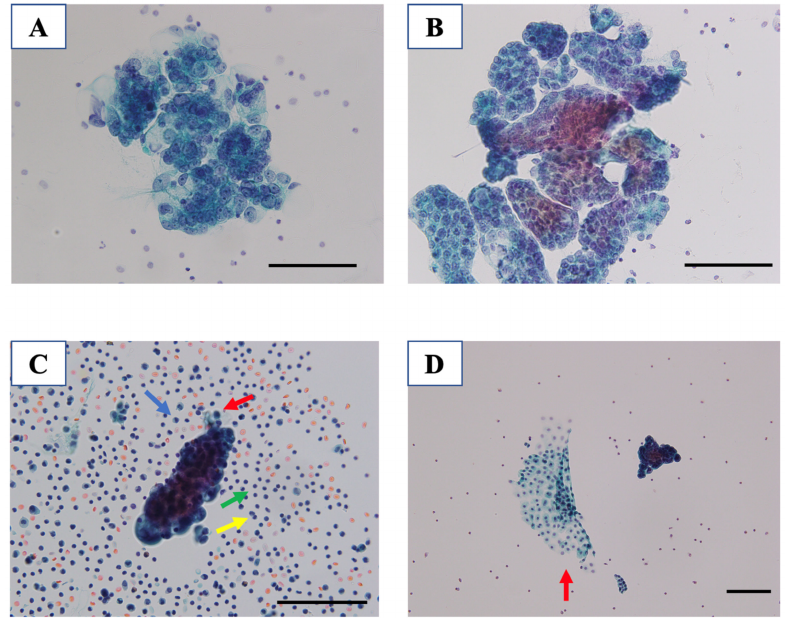
Figure 1. Representative images of cytology of malignant ascites of ovarian cancer and aggregated spheroids. Morphology is the most important information to distinguish malignant cells from non-malignant cells. Even in malignant ascites, there are many non-malignant cells, and some of them change their morphology by a variety of stimulations. ( A , B ) Papanicolaou staining of malignant ascites of epithelial ovarian cancer. Various sizes and shapes of spheroids are observed. ( C ) In malignant ascites, non-malignant cells, including macrophages (blue), mesothelial cells (red), lymphocytes (green), and neutrophils (yellow) are also detected. ( D ) Aggregation of mesothelial cells (red) is also observed. Scale bar: 100 µ m. These data were acquired in our pathological unit using Papanicolaou staining from three different patients with advanced EOC (histological type were all high-grade serous ovarian